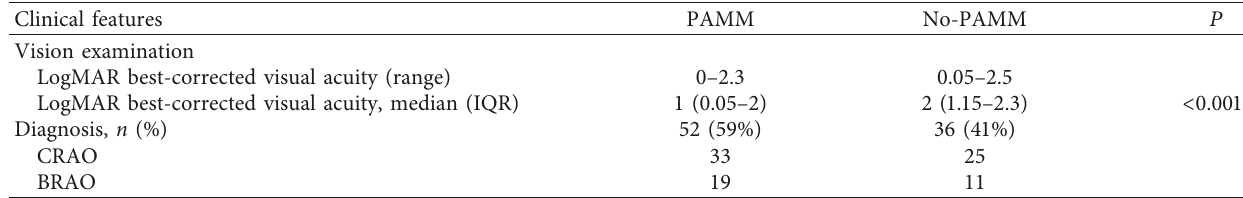
Figure 2: Paracentral acute middle maculopathy (PAMM) manifestation by optical coherence tomography angiography (OCTA) ex- amination. (a) Enface image of the middle layer of the retina, with multiple patchy strong reflection lesions in the center of the macula. (b) Deep capillary plexus (DCP) blood flow density in the macular area decreases and the foveal avascular zone (FAZ) area increases. Table 3: Differences in clinical features during follow-up before discharge between groups with and without PAMM clinical data in patients with retinal artery